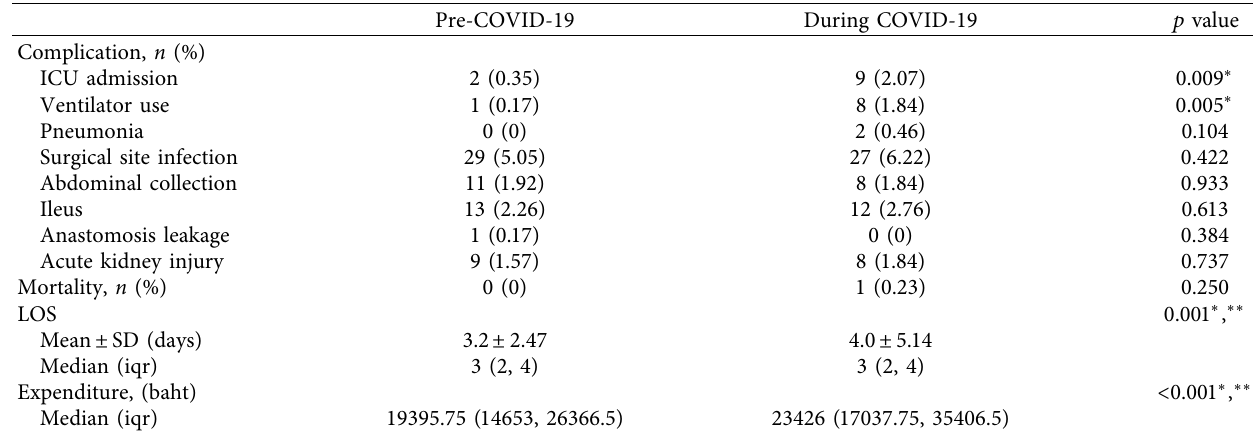
Table 3: Outcome of the treatment in adult patients with acute